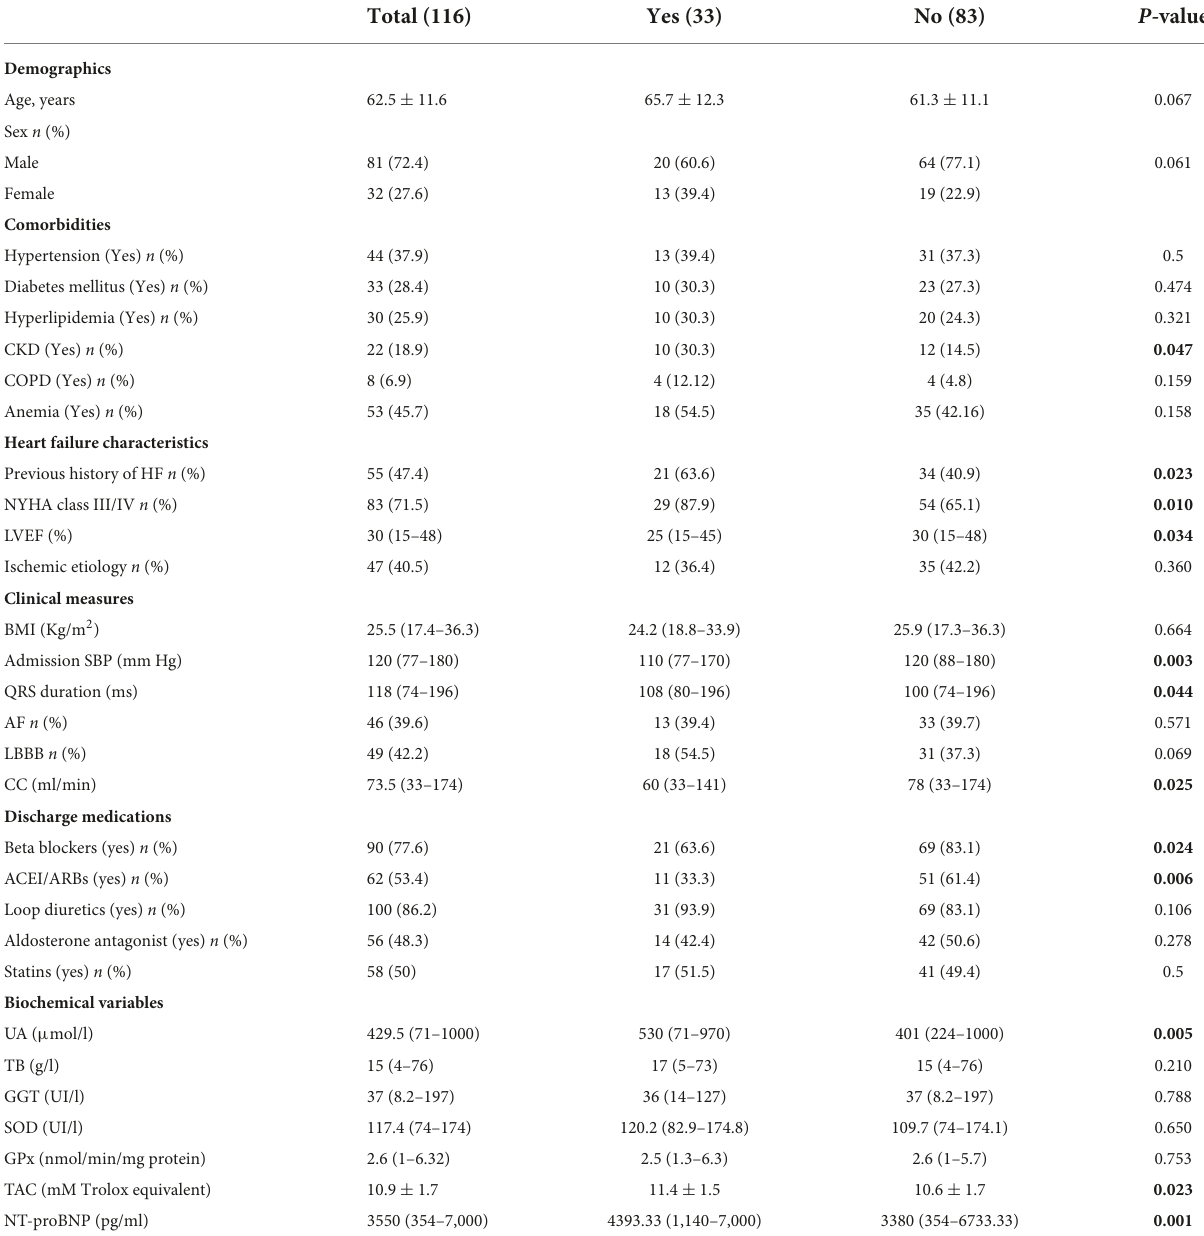
TABLE 1 Baseline characteristics of study patients stratified according to prognosis outcome. Post-discharge mortality during follow-up Total (116) Yes (33) No